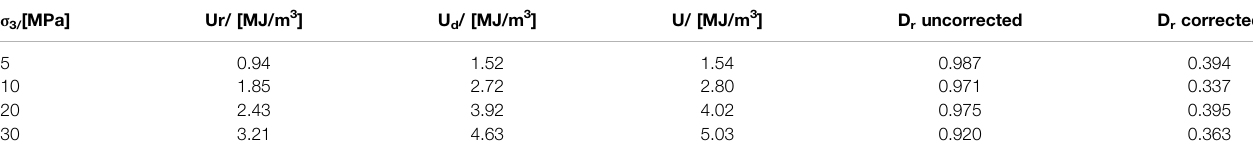
TABLE 4 | Table of energy characteristic values and critical damage values for different con fi ning